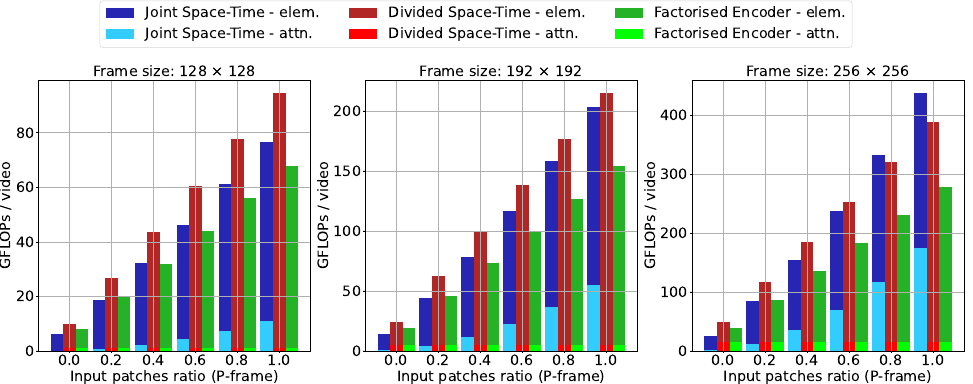
Figure 2. Computational cost of attention matrix calculation (”attn”) and element-wise calculation (”elem”) in TimeSformer for each resolution and type of attention when changing the percentage of reduction in the number of patches for P-frames. The number of blocks in the Transformer is set to 12, the input is 1 GoP (i.e., 1 I-frame and 11 P-frames), and the patch size is uniformly set to